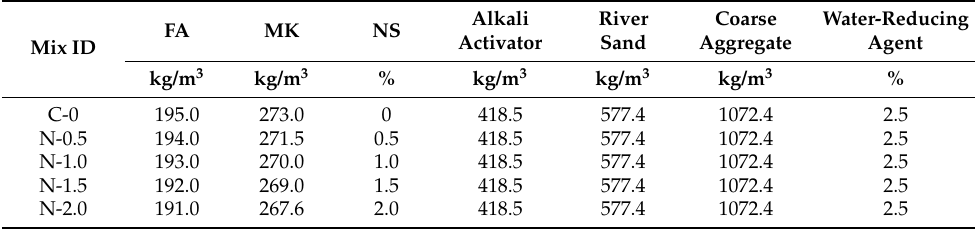
Table 5. The mix proportions of NS–GPC.